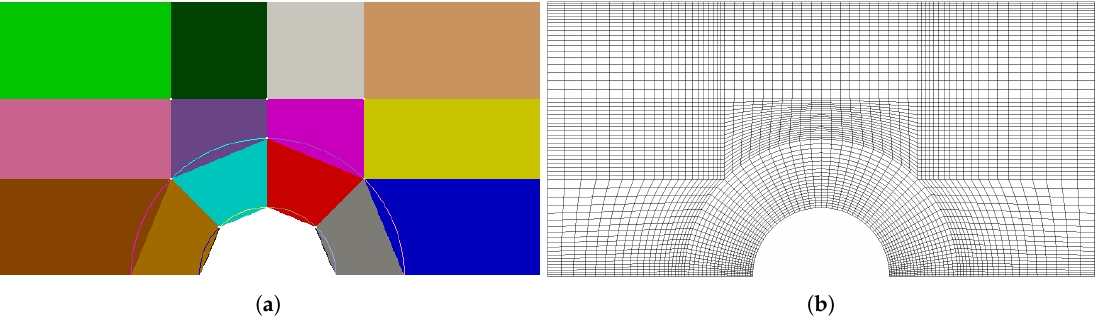
Figure 7. ( a ) Configurations of 14 blocks of a single cylindrical corrugation; and ( b ) local mesh refinement around the cylindrical corrugated wall (coarse mesh).